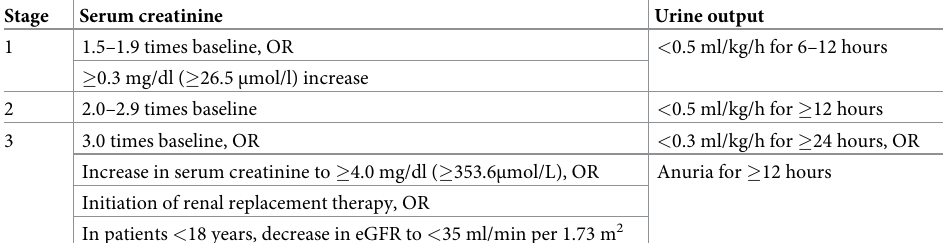
Table 1. AKI staging according to the KDIGO